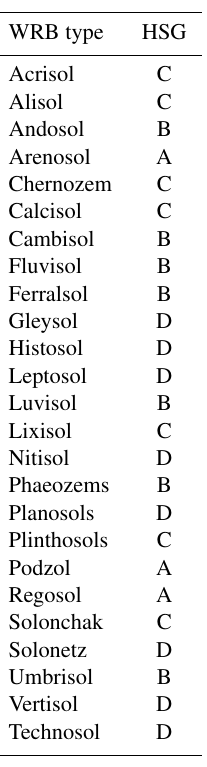
Table A4. Reclassification of World Reference Base (WRB) soil types to Hydrological Soil Groups (HSG).